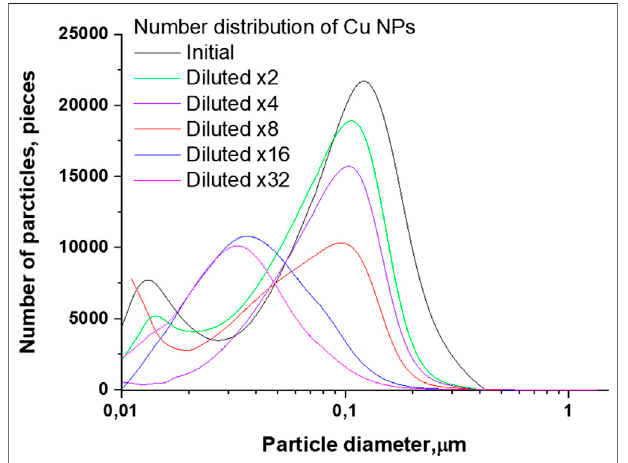
FIGURE 5 | Size distribution of Cu nanoparticles depending on the amount of initial colloid dilution.